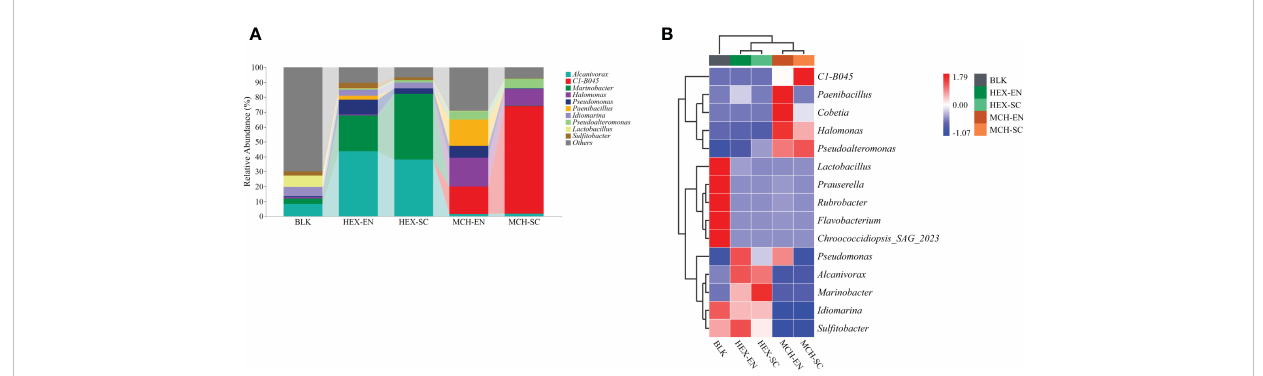
FIGURE 2 Pro fi le of different hydrocarbon-degrading bacterial communities derived from the CIR core sediment. (A) The bacterial community structures of the HEX/ MCH-degrading enrichment cultures and subcultures. The top 10 most dominant genera are illustrated in the plot. MCH denotes methylcyclohexane- spiked cultures; HEX denotes n-hexadecane-spiked cultures; BLK denotes the original bacterial communities of the CIR core sediment without the addition of any carbon source; EN denotes enrichment cultures; SC denotes subcultures. (B) Differentiated genera in the HEX/MCH-spiked treatments demonstrated by a standardized heatmap. The tree on the left of the plot is generated based on clustering the relative abundance of the top 15 most dominant genera in each treatment. Red color denotes higher abundance, while blue color denotes lower abundance.